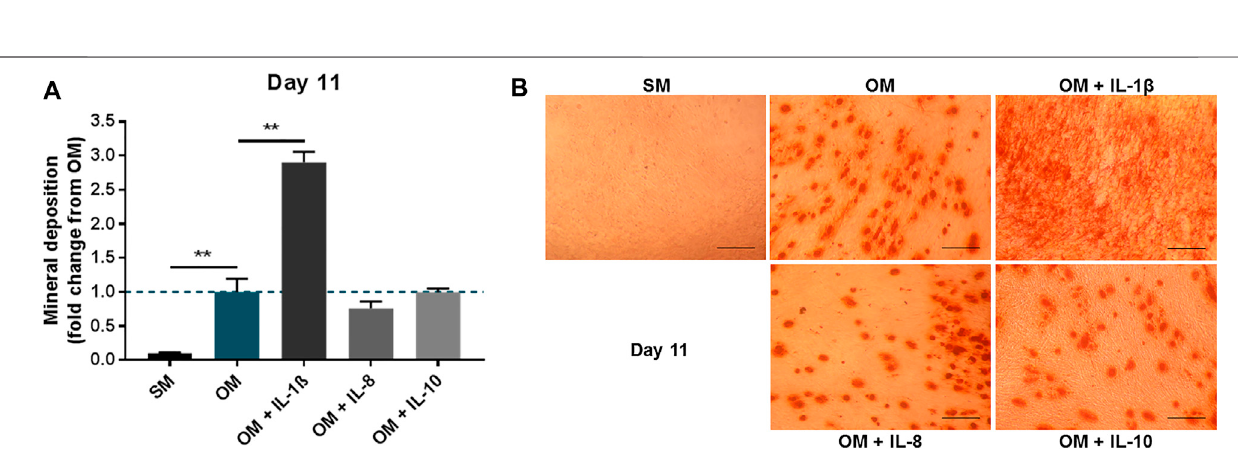
Frontiers in Bioengineering and Biotechnology |